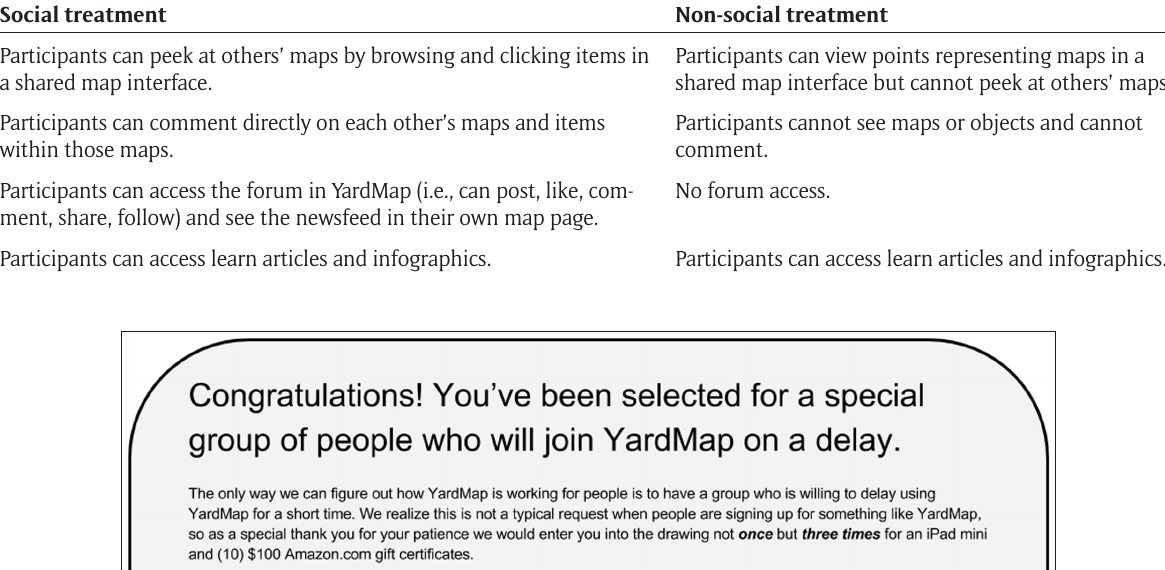
Table 2: Different kinds of experiences available to participants in the social vs. non-social version of the YardMap Web Application.